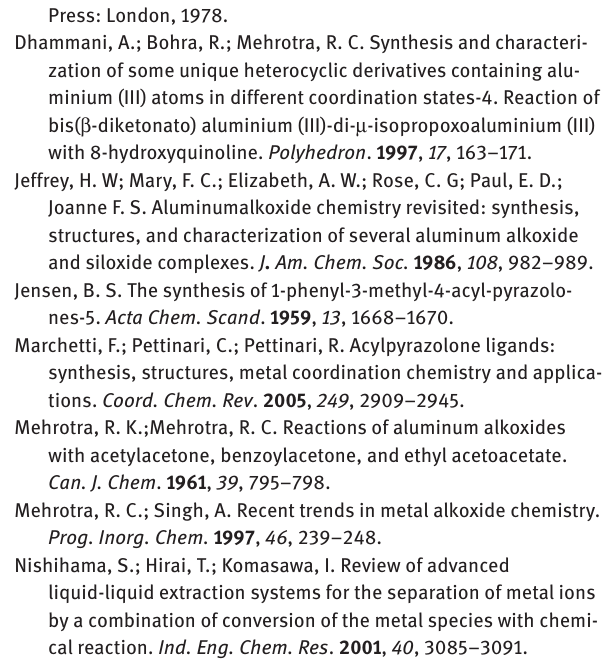
Table 3: Synthetic, physical, and analytical data of compounds [RC(O)C:C(O)N(Ph)N:CCH Compound R Empirical formula,